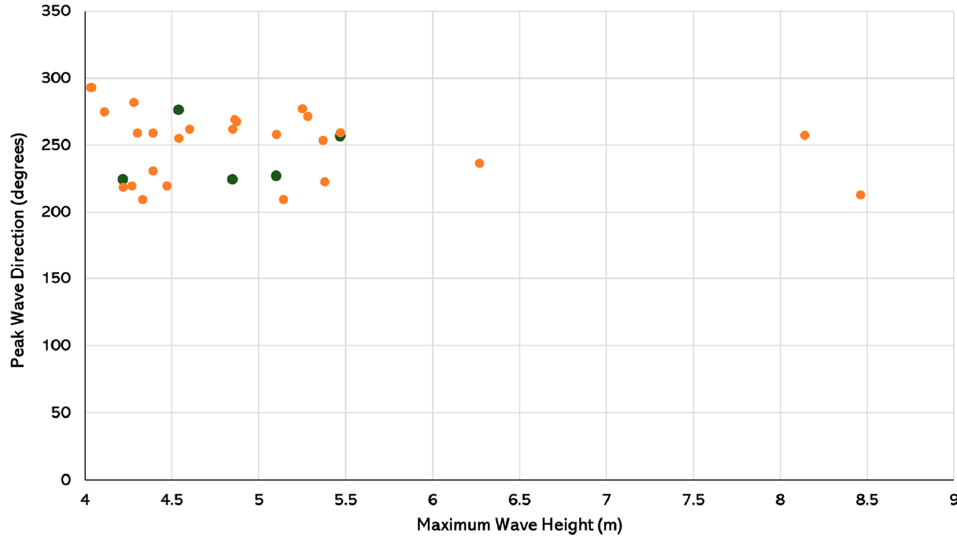
Figure 5. Peak wave direction versus maximum wave height for the 32 largest rogue waves that were identified in this study. The five waves that were associated with Hurricane Michael are shown in dark green.